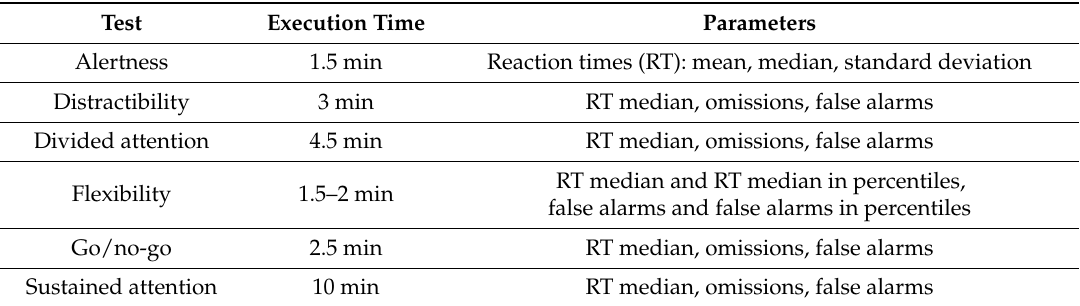
Table 3. Parameters in each KiTAP